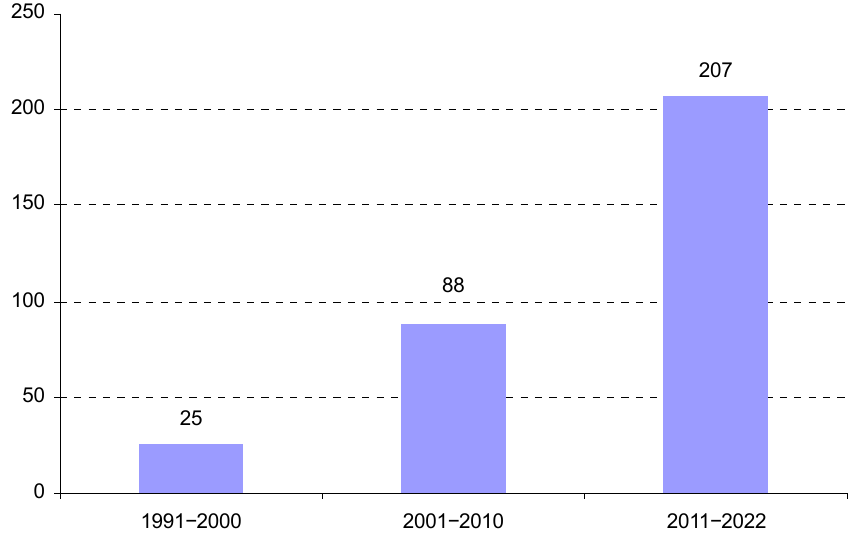
Figure 1. Number of publications in the study area between 1991 and 2022 (based on Scopus, 8 June 2022).